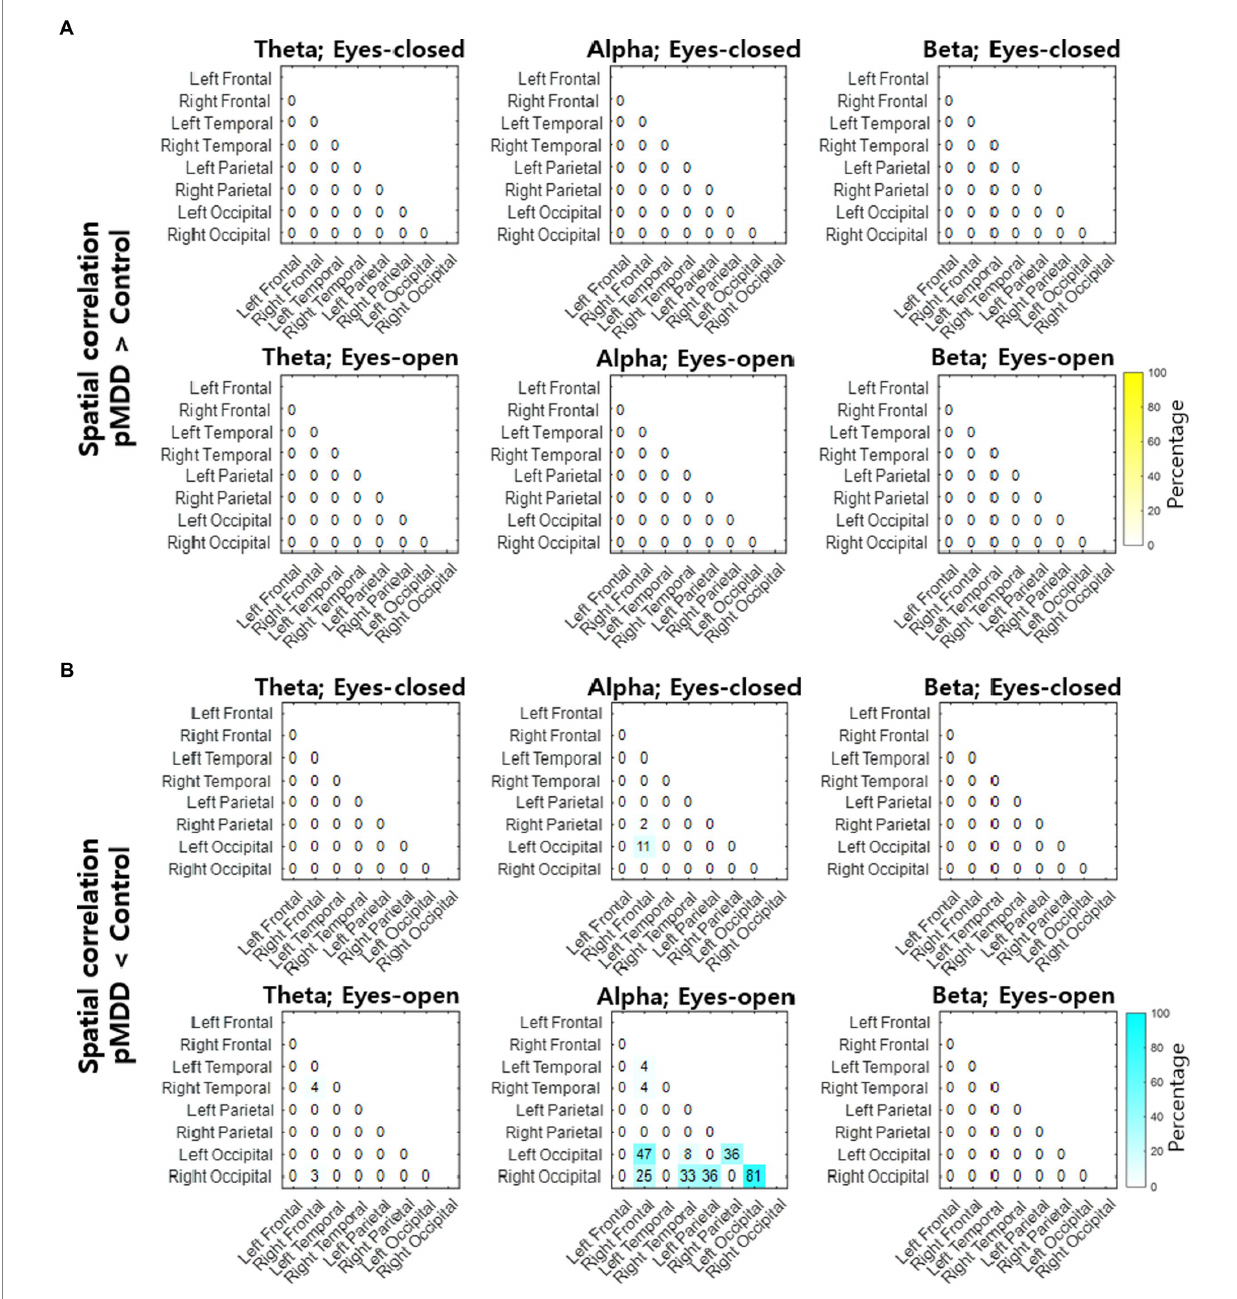
FIGURE 6 Differences of spatial correlation of infraslow amplitude fluctuations between past major depressive disorder and control groups. (A) The ratio (percentage) of channel pairs that the spatial correlation was significantly higher in pMDD than in control group (rank-sum test, FDR-corrected p < 0.05). (B) The ratio (percentage) of channel pairs that the spatial correlation was significantly lower in pMDD than in control group (rank-sum test, FDR- corrected p <